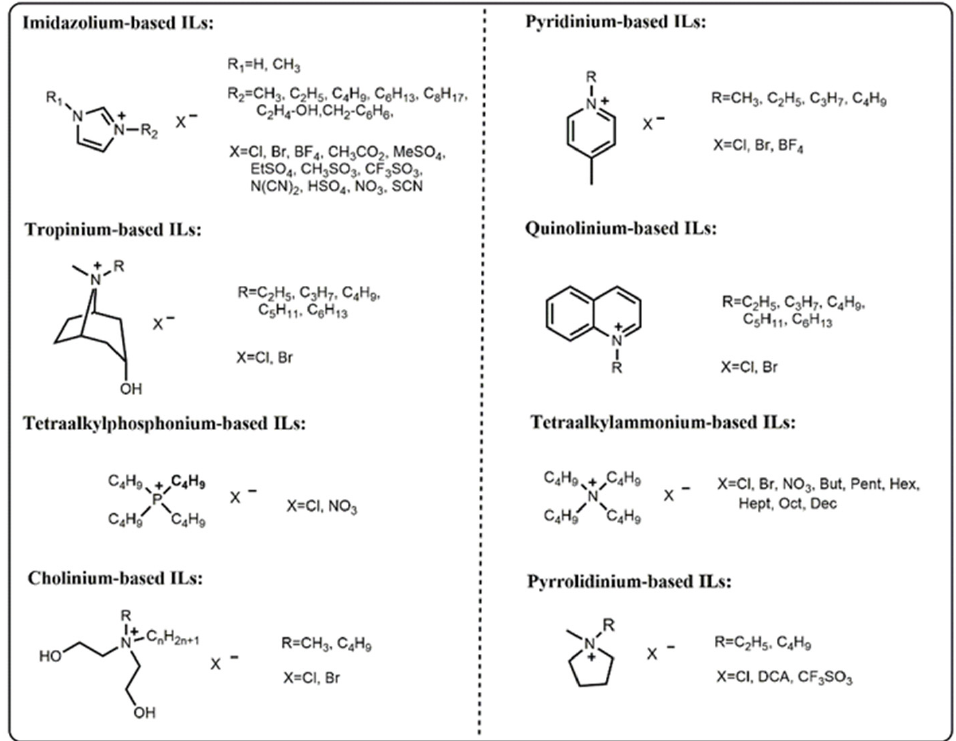
Figure 1. Chemical structure of the ILs commonly used for ATPSs.